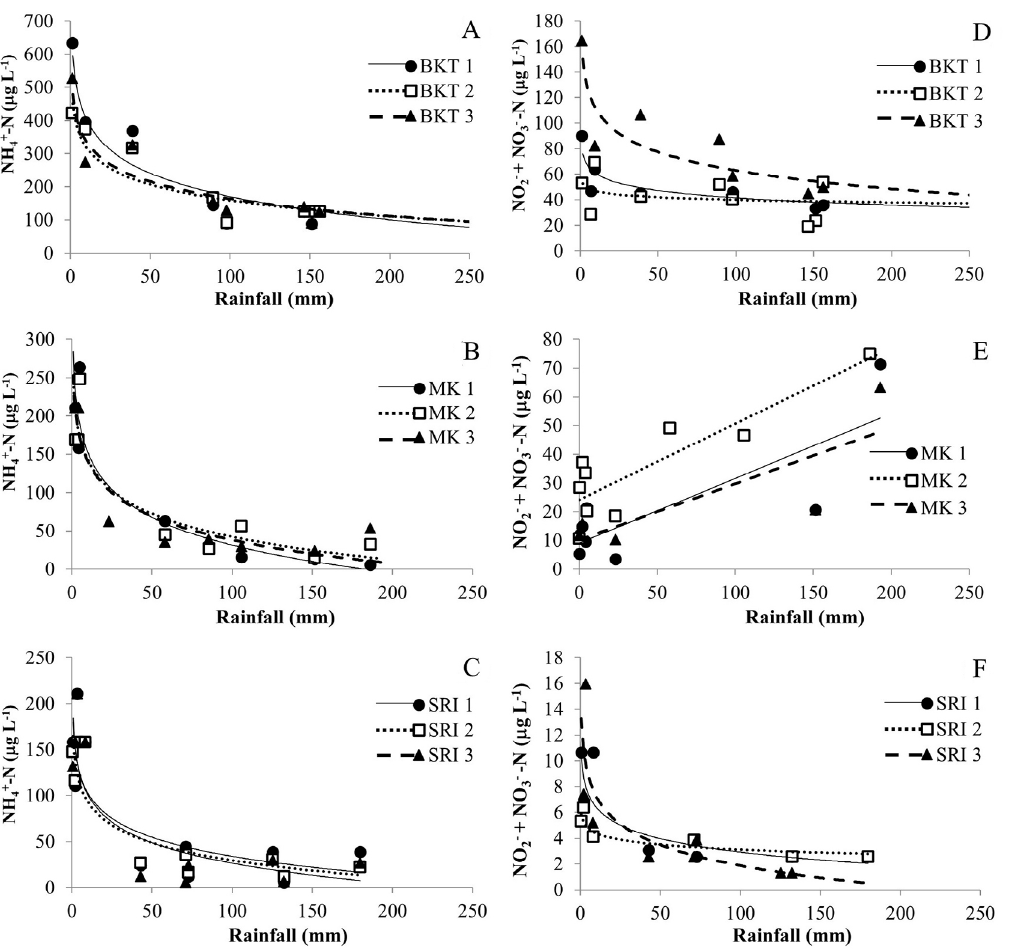
Fig. 4. – Correlation between rainfall and ammonium-nitrogen (NH 4+ -N) (A, B and C), and correlation between rainfall and nitrite and nitrate- nitrogen (NO 2– +NO 3– -N) (D, E, and F) at each sampling station in the pond area of Bang Khun Tien (BKT), the estuary area of the Maeklong river mouth (MK) and the coastal area of Sriracha (SRI) based on monthly measurements from January to December